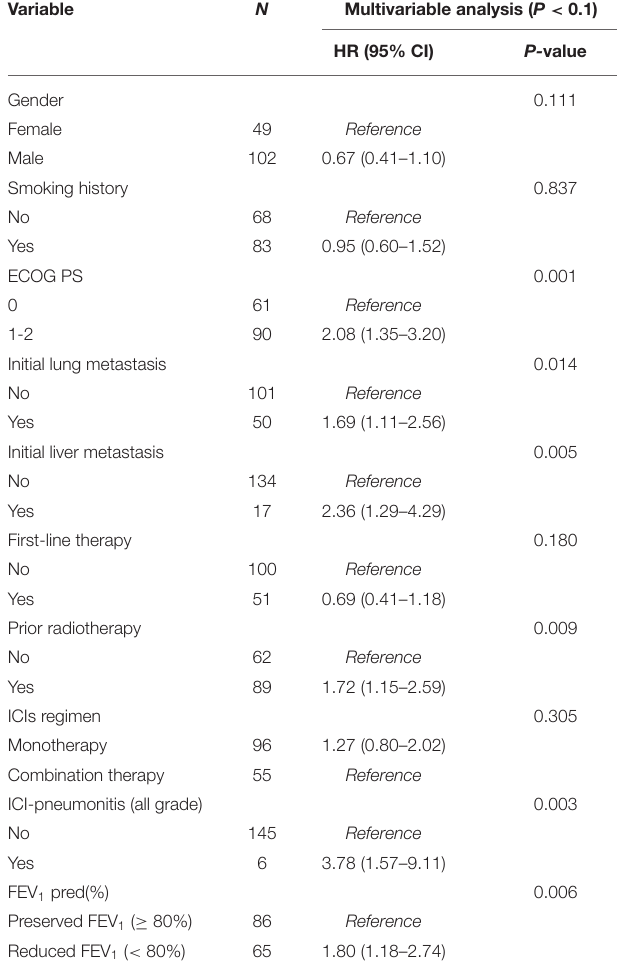
TABLE 2 | Factors associated with progression free survival by Cox regression model in all patients received immune checkpoint inhibitors (80% of predicted FEV 1 as a cut-off value of FEV 1